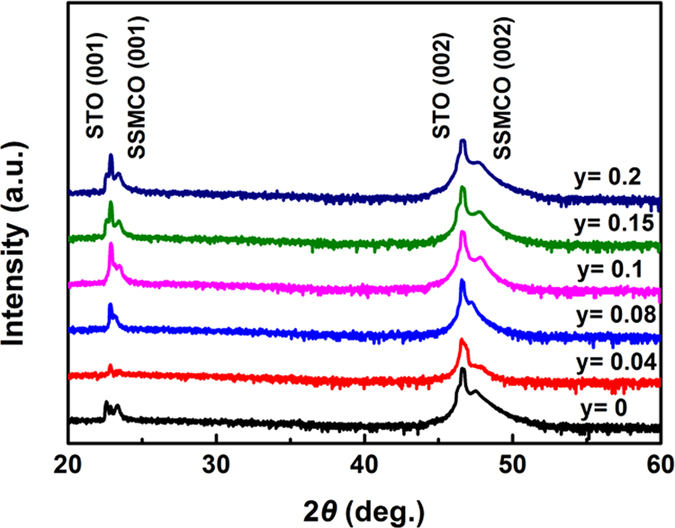
XRD patterns of the Sm0.5Sr0.5Mn1−yCryO3 (y = 0, 0.04, 0.08, 0.1, 0.15, and 0.2) thin films.